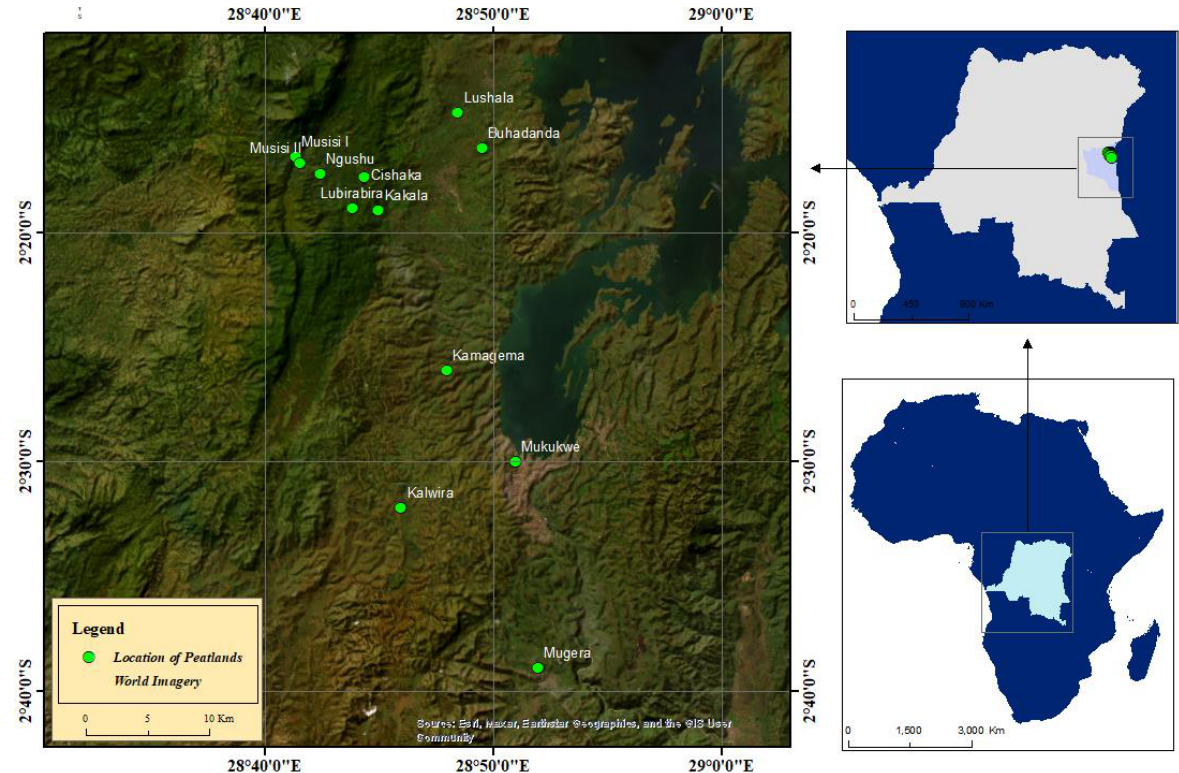
Figure 1. Locations of the main peatlands in Sud-Kivu Province, DRC. The insets show the locations of the DRC within Africa (below) and of Sid-Kivu Province and its peatlands within the DRC